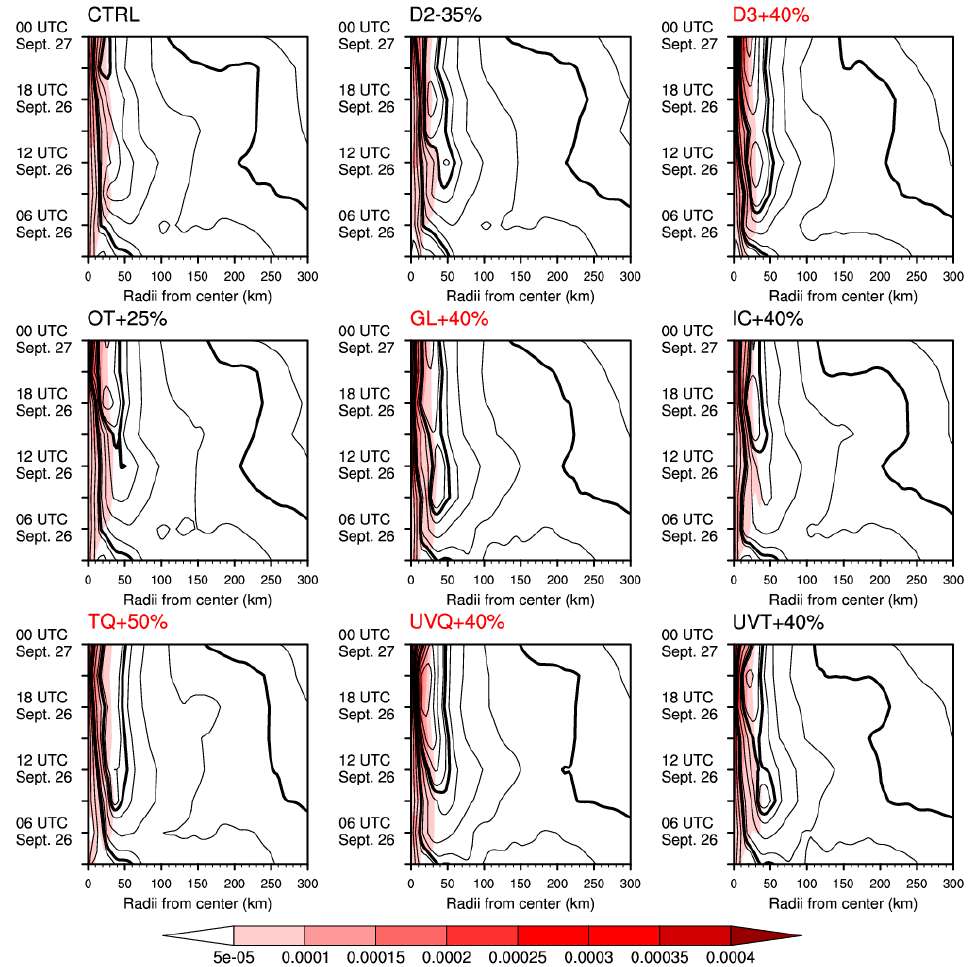
Figure 5. Hovmöller diagram of the mean vertical component of relative vorticity (shaded; s − 1 ) and isotachs of the mean tangential wind component (contour interval 5 m s − 1 ) at 910 hPa. Thick contours show the location of gale-force (17 m s − 1 ) and hurricane-force (33 m s − 1 ) winds. Ensemble forecast members with red titles reproduce the RI.